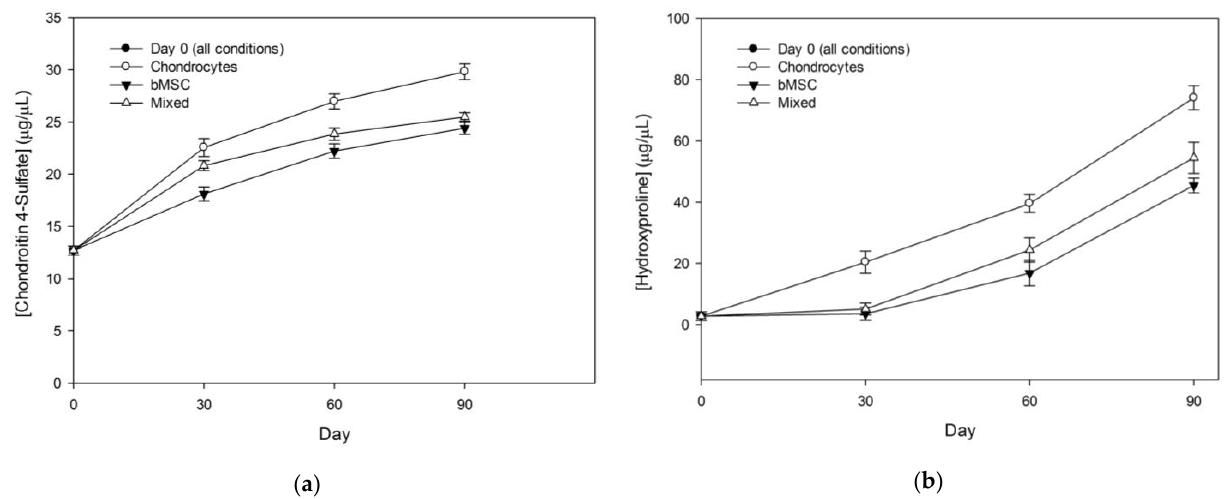
Figure 15. Quantitative measurements of the cartilage matrix components deposited by cells during the 90-day encapsulation culture. ( a ) Sulfated GAGs expressed as chondroitin sulfate; ( b ) collagen content expressed as hydroxyproline. Error bars indicate standard deviation. Note that day 0 values reflect the inclusion of chondroitin 4-sulfate and collagen I in the initial encapsulation solutions.